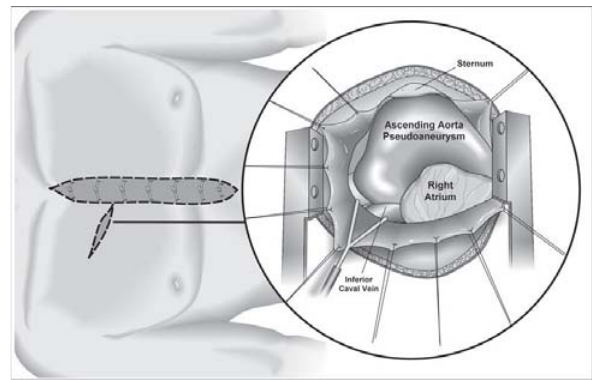
Fig. 4 - Surgery diagram illustrating the surgical approach and location of the pseudoaneurysm close to the sternum. See the location of our surgical wound at the right parasternal area